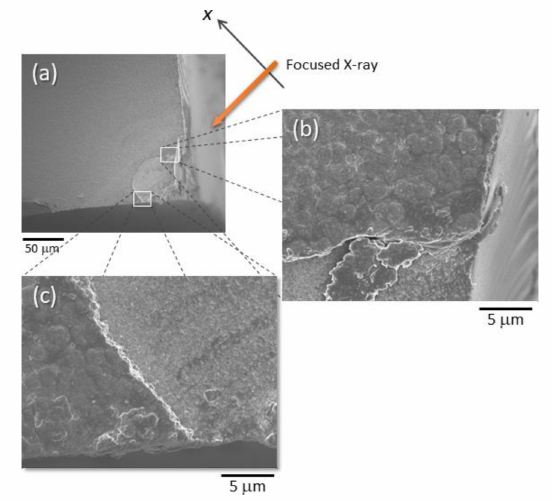
Figure 6. Top views of X-ray scanned sample observed by SEM. Image of the sample corner, which was scanned by X-ray (indicated by an arrow), in low magnification are shown in ( a ). The magnified images within ( a ) are shown in ( b , c ).